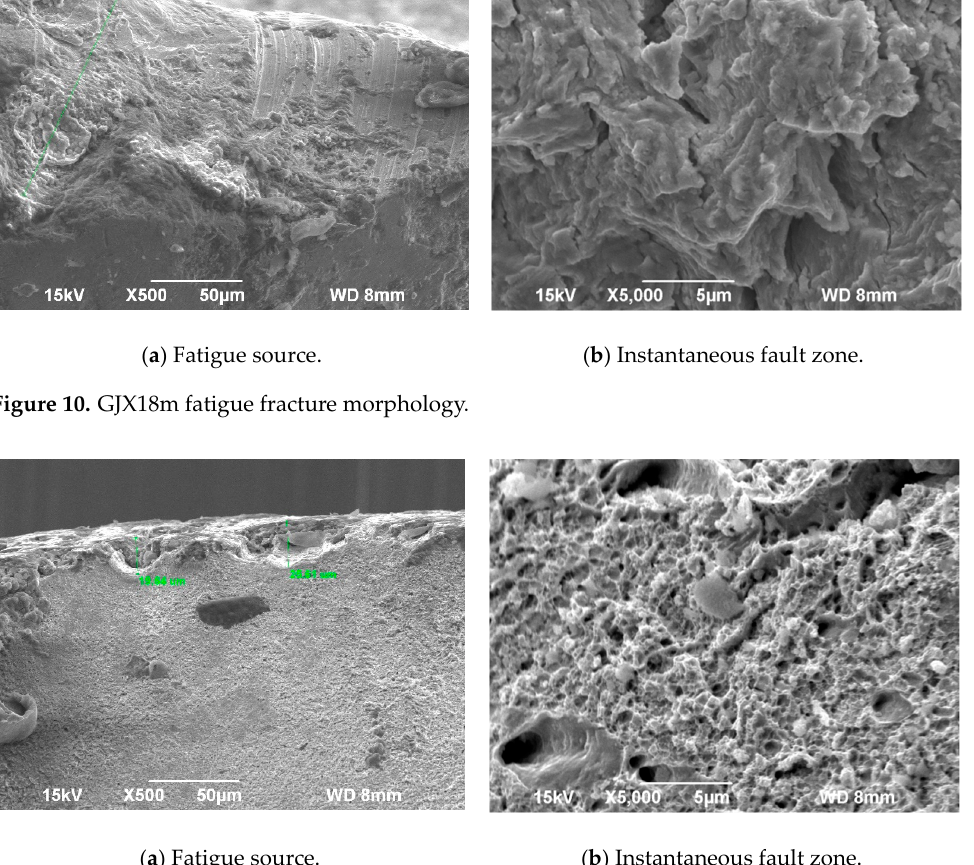
Figure 11. GJX2y fatigue fracture morphology.